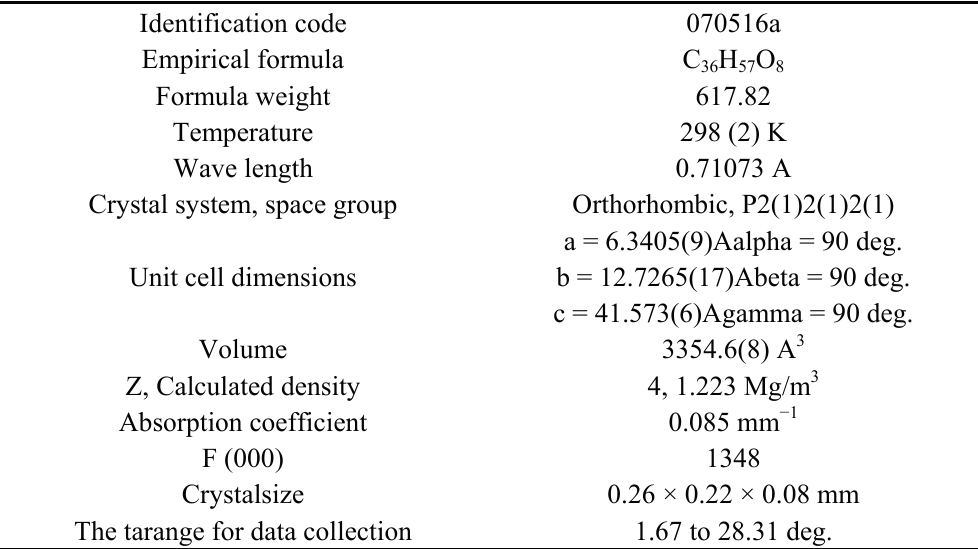
Table 2. Crystal data and structure refinement for